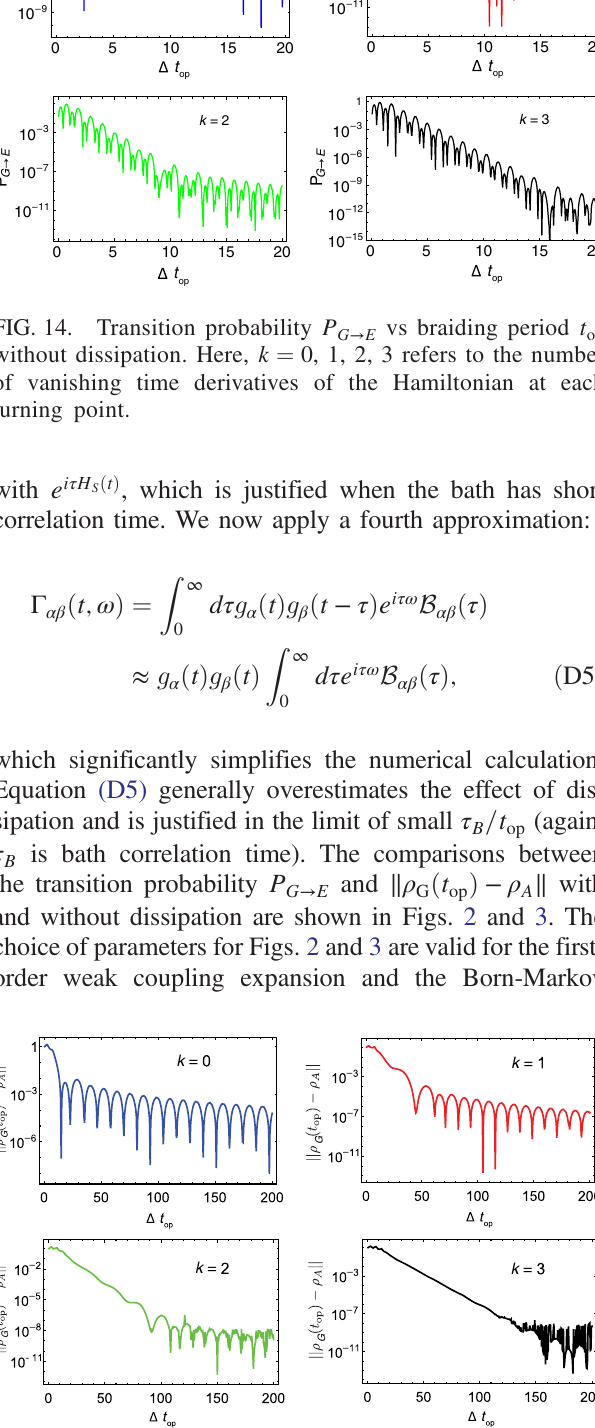
FIG. 15. Phase error ∥ ρ t without dissipation. Here, k ¼ 0 , 1, 2, 3, 4 refers to the op number of vanishing time derivatives of the Hamiltonian at each turning